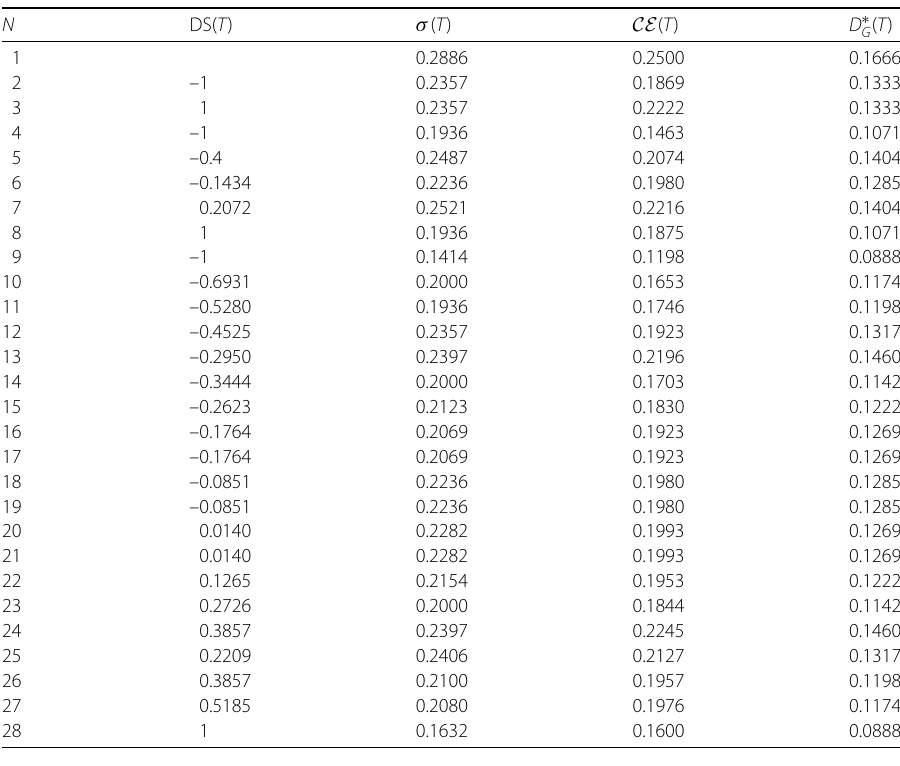
Table 3 DS, standard deviation, CE, and the Gini mean difference for all coherent system with 1–4 i.i.d components having uniform distribution in